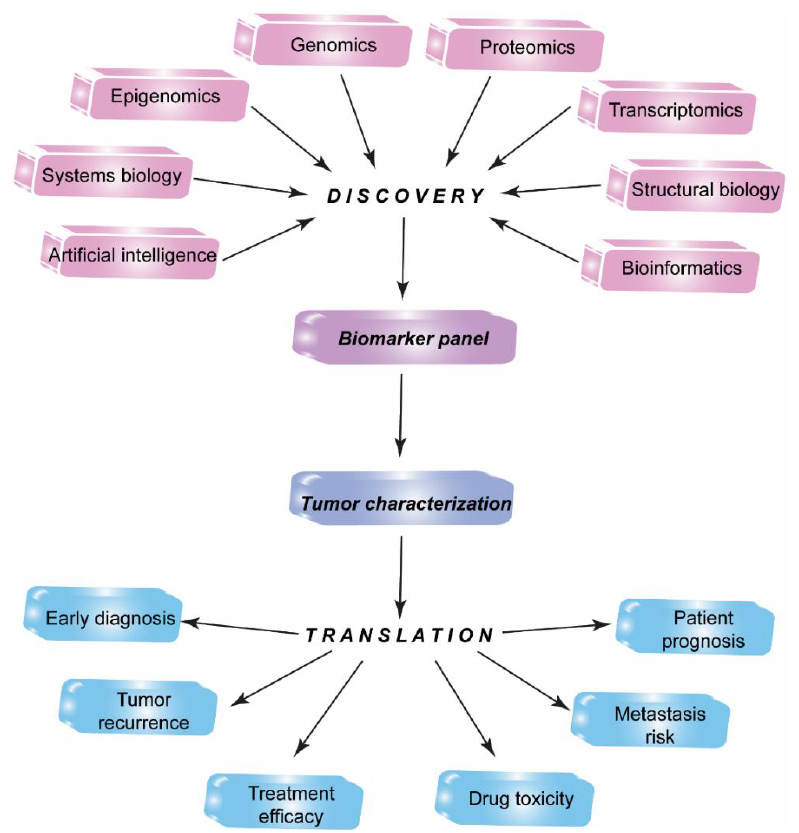
Figure 1. Multiomics biomarker discovery for translational medicine. Integrated high-throughput proteomics, genomics, epigenomics, transcriptomics, bioinformatics approaches along with systems biology, structural biology, artificial intelligence techniques allow identification of a candidate biomarker panel to discover new biomarkers for translation into practical medicine.